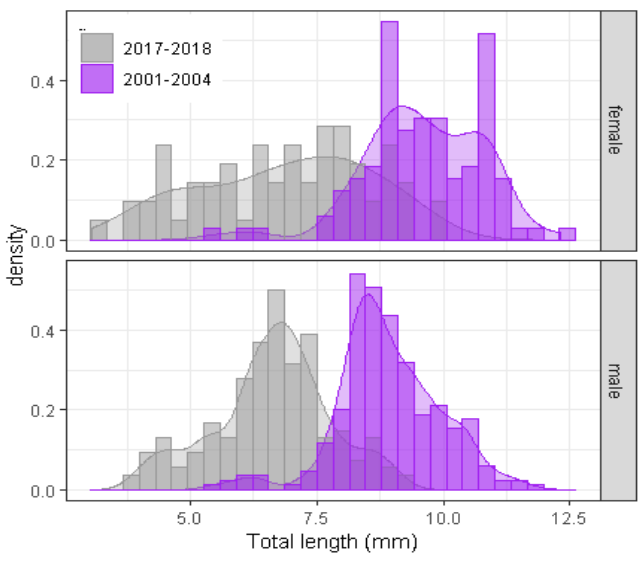
Figure 3. Comparison between 2017–2018 (grey) and 2001–2004 (purple) data [22] on body length of females (top) and males (bottom) of Orconectes limosus in Lake Maggiore. Histograms represent the observed values, whereas the smoothed line is the kernel density estimate of the distribution.